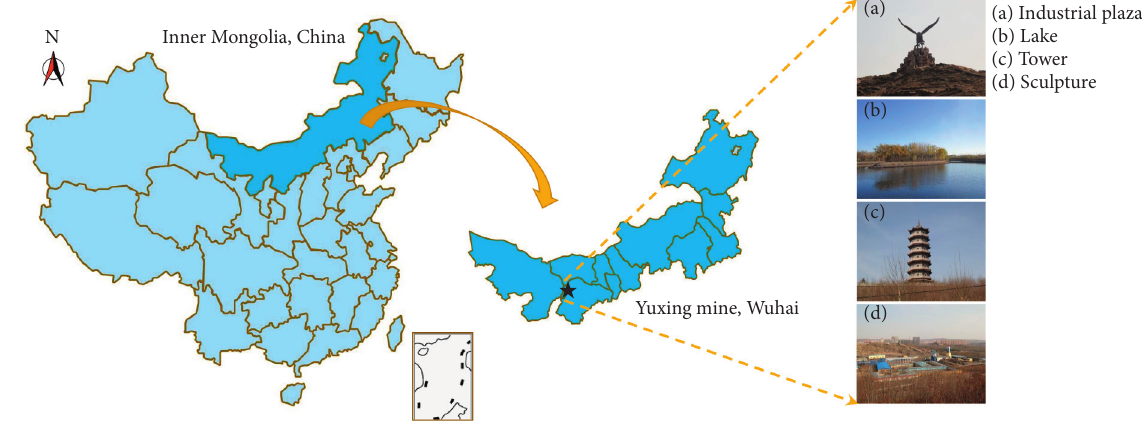
Figure 1: Overview of the Yuxing mine.